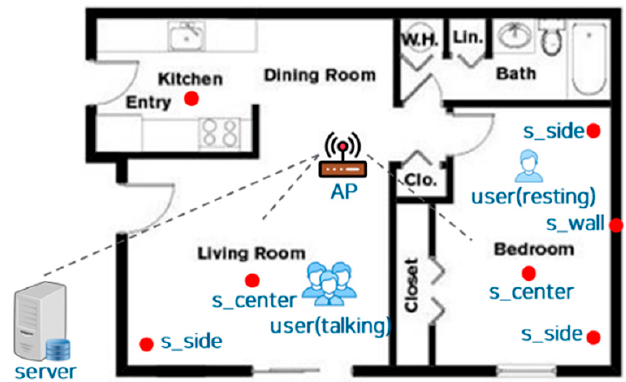
Figure 4. The Real-Use Environment of a Floor Noise Level Meter.